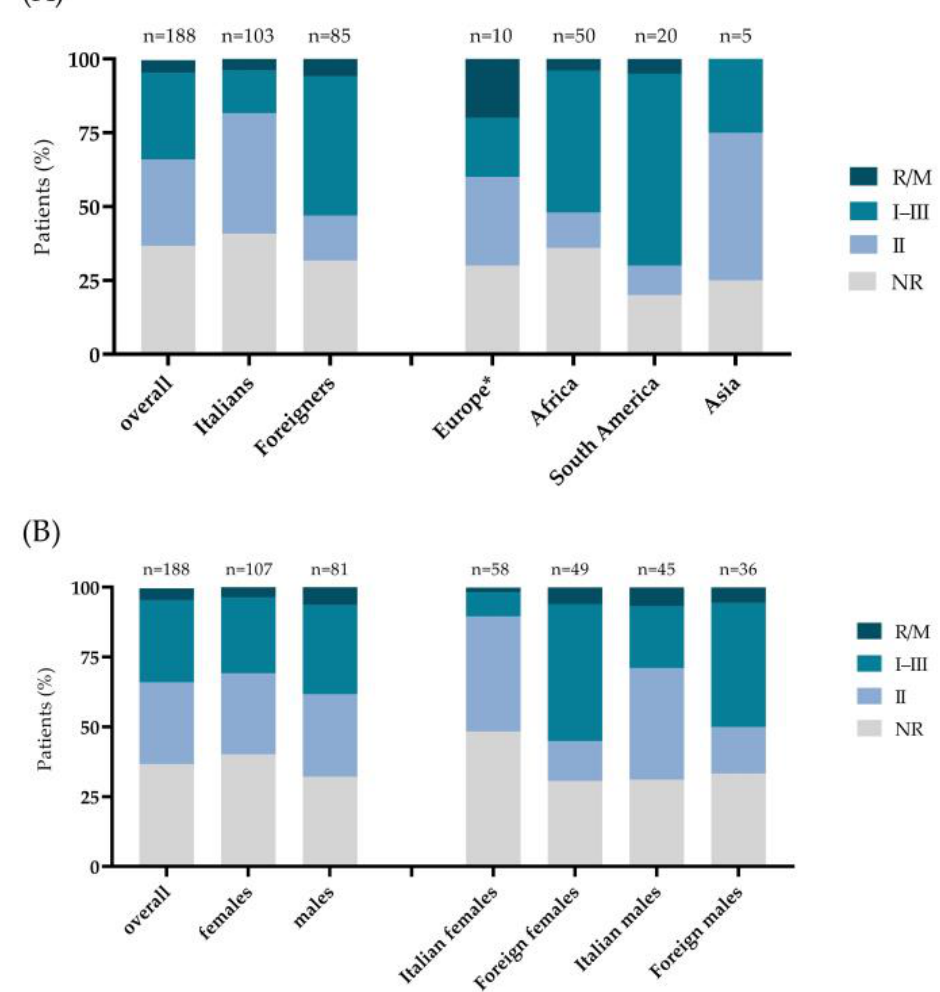
Figure 2. Distribution of T. gondii serotypes ( A ) in the overall population stratified by nationality (Italians, foreign) and place of birth (Europe, Africa, South America, Asia) and ( B ) in the overall pop- ulation stratified by sex (females, males) and by sex and nationality (Italian females, foreign females, Italian males, foreign males). p -values are based on the Chi-square test. * Europe without